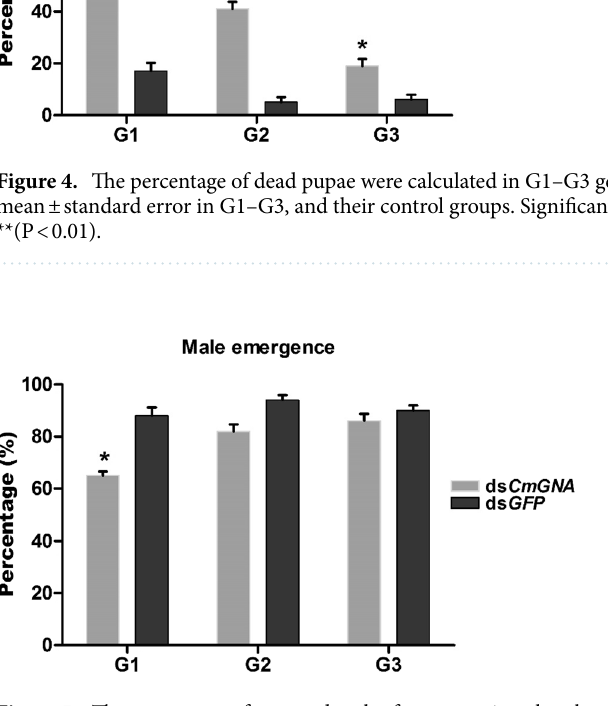
Figure 5. The percentage of emerged males from pupation chamber were calculated in G1–G3 genrations. Each point indicates the mean ± standard error from G1–G3 generations, and their control groups. Significant differences indicated by *(P < 0.05), **(P <